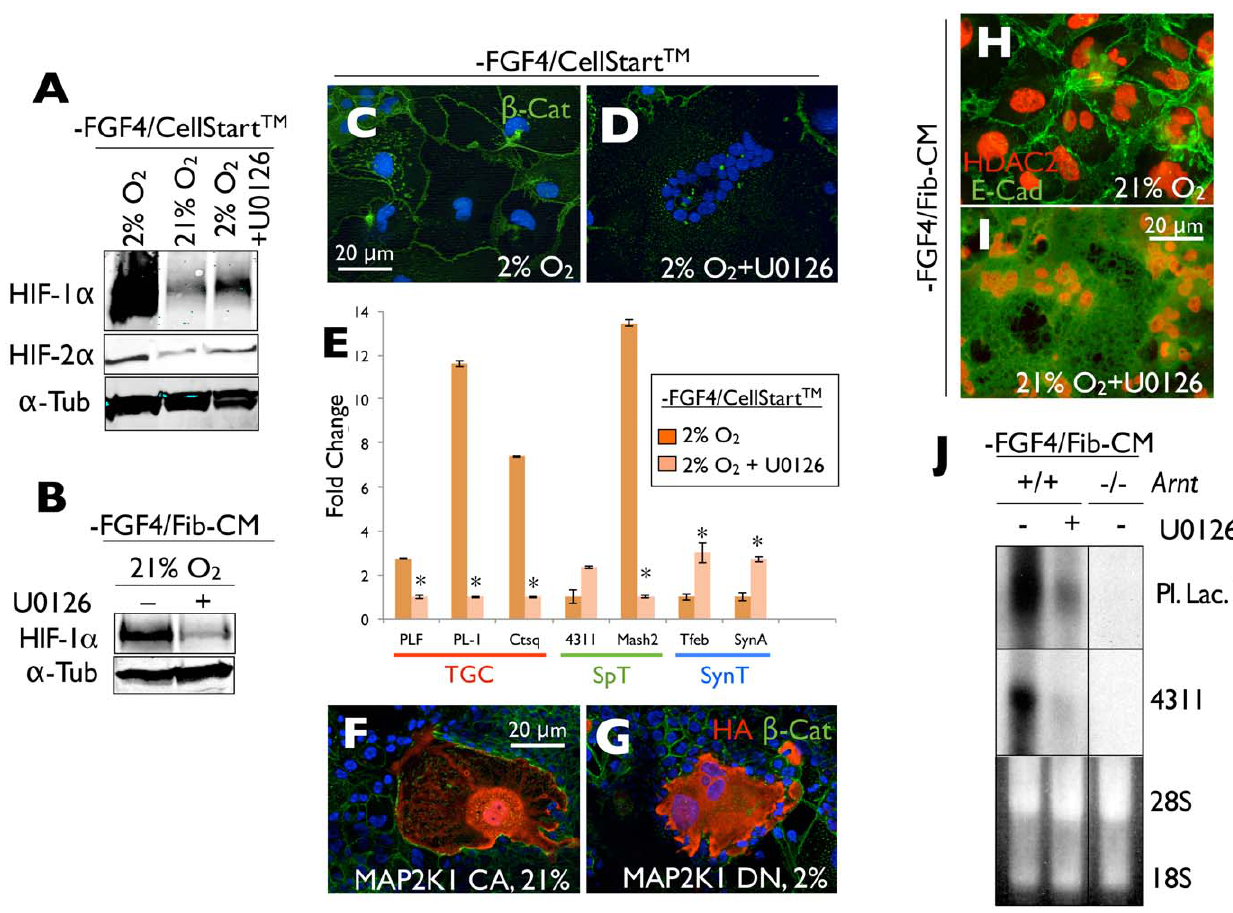
Figure 3. ECM- or oxygen-dependent HIF - a subunit stabilization and TGC formation are dependent on MAP2K1/2 activity. (A) Immunoblot of whole cell lysates obtained from TSCs differentiated in 2% or 21% O 2 , with and without U0126, following culture on CELLstart TM , for HIF-1 a , -2 a or a -Tubulin. (B) Immunoblot of whole cell lysates obtained from differentiated wild-type TSCs following culture on TC plastic in Fib-CM with and without U0126 with a HIF-1 a antibody. (C) (D) Immunofluorescence microscopy of TSCs maintained on CELLstart TM following differentiation for 7 days under hypoxic conditions without and with U0126 (10 uM) using anti b -Catenin antibodies (green) (blue=Dapi). (E) Quantitaive RT-PCR analysis of Plf, Pl-I, Ctsq, 4311, Mash2, Tfeb and SynA expression following differentiation of wild-type TSCs cultured on CELLstart TM under hypoxic conditions without and with U0126. p values , 0.05 versus drug free control indicated by an asterisk. (F) Immunofluorescence microscopy using anti HA (red) and b -Catenin (green) antibodies of control TSCs differentiated following culture on CELLstart TM under 21% O 2 following transient tranfection with constitutively active HA:MAP2K1 or under (G) 2% O 2 following transient transfection with dominant negative HA:MAP2K1. (H, I) Immunofluorescence microscopy of wild-type TSCs differentiated following culture on TC plastic in Fib-CM in 21% O 2 with and without U0126 with antibodies for HDAC2 (red) and E-Cadherin (green). (J) Northern blot analysis of lineage specific marker gene expression in wild-type TSCs maintained on TC plastic in Fib-CM and differentiated with and without U0126, compared with differentiated Arnt 2 / 2 TSCs.